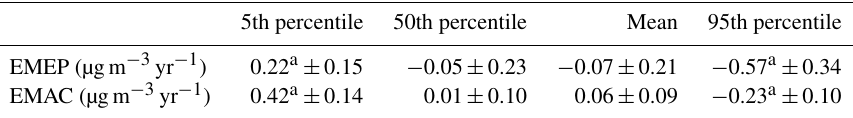
Table 2. Modeled and observed ozone trends ∗ and their standard deviations based on diurnal average European mean ozone concentrations. The mean, 5th, 50th, and 95th percentile represent the monthly statistics of the diurnal averages. The model has been sampled in the same location as the EMEP stations.